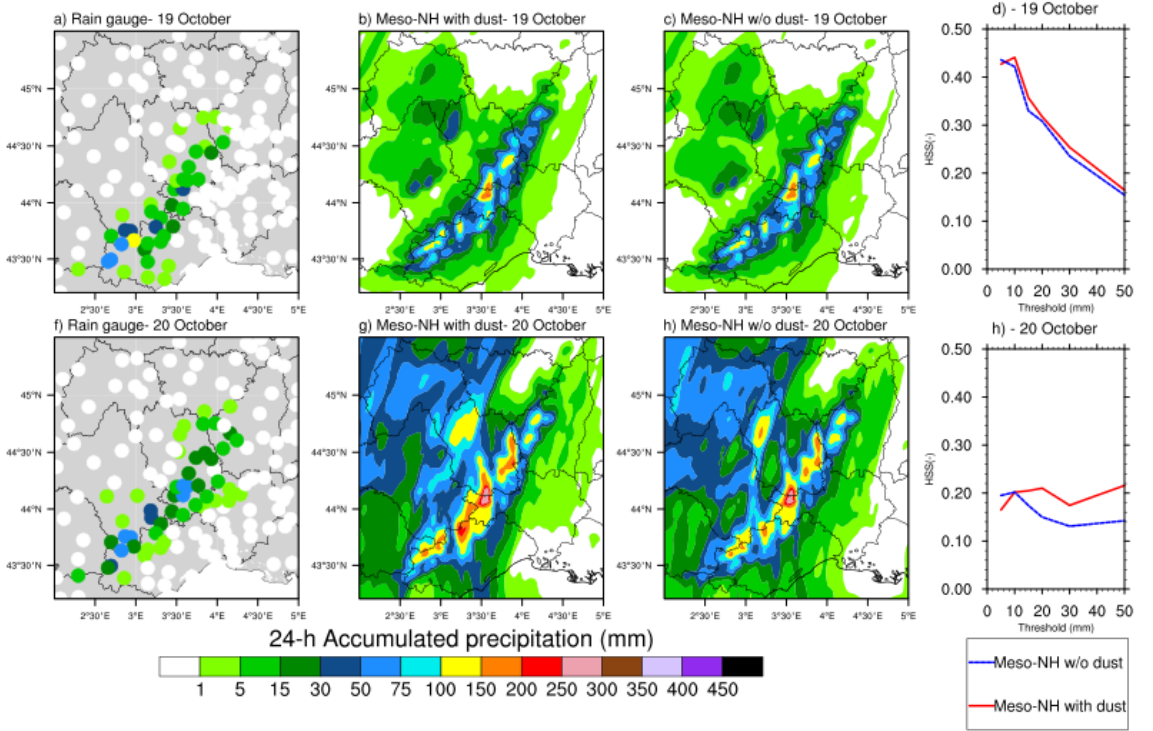
Figure 3. (a) 24h of accumulated rainfall from 00:00UTC on 18 October derived from the rain gauge network in the CV domain. (b) 24h of accumulated rainfall derived from the DUST Meso-NH simulation. (c) same as (a) but for the NODUST Meso-NH simulation. (d) HSS as a function of the rainfall threshold for the DUST simulation (solid red line) and the NODUST simulation (solid blue line). (e–h) same as (a–d) , respectively, but for 24h of accumulated rainfall from 00:00UTC on 19 October